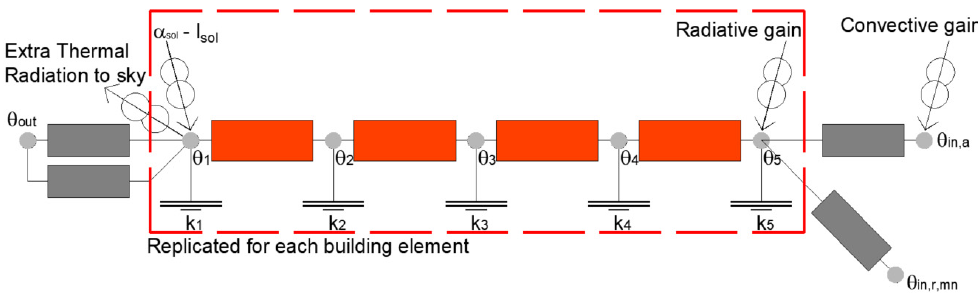
Figure 1. Resistance-and-capacitance (RC) network thermal model. Personal elaboration from UNI EN 52016 [28].